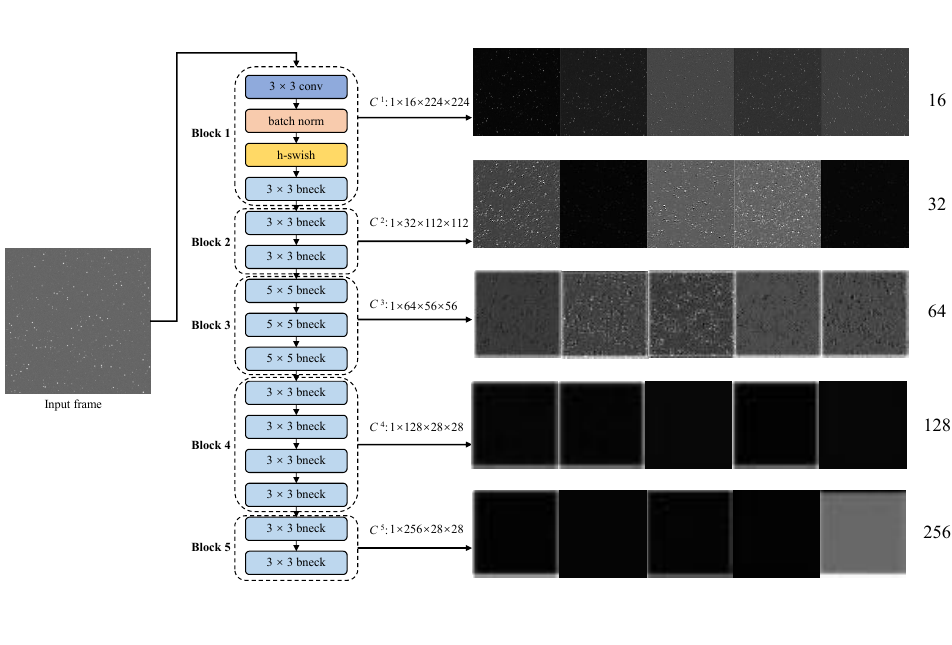
Figure 3. Spatial feature extraction module. The black squares on each line denote the first five outputted feature maps of each block. The number at the end of each line means the number of extracted feature